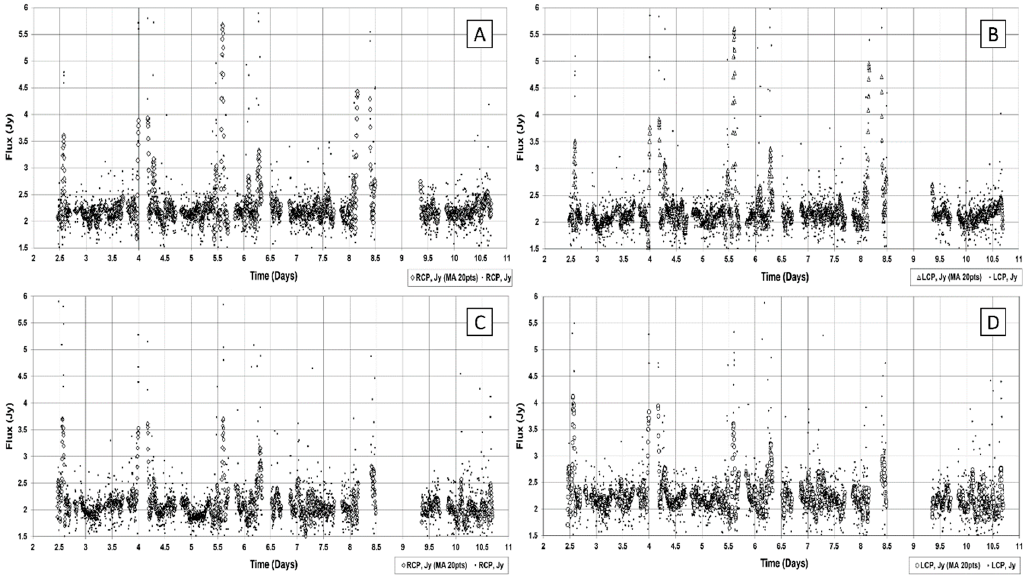
Figure 1. Initial (raw) and smoothed data of observations of BL Lac object 3C 371 at frequencies 5 and 6.1 GHz, in September 2019, on the 16-m VIRAC antenna (Latvia). ( A ) 5 GHz, RCP; ( B ) 5 GHz, LCP; ( C ) 6.1 GHz, RCP; ( D ) 6.1 GHz, LCP. ( C ) 6.1 GHz, RCP; ( D ) 6.1 GHz,